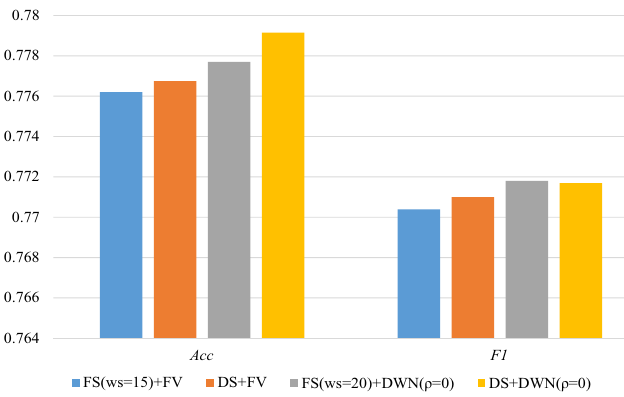
Figure 7. Classification performance of FS and DS